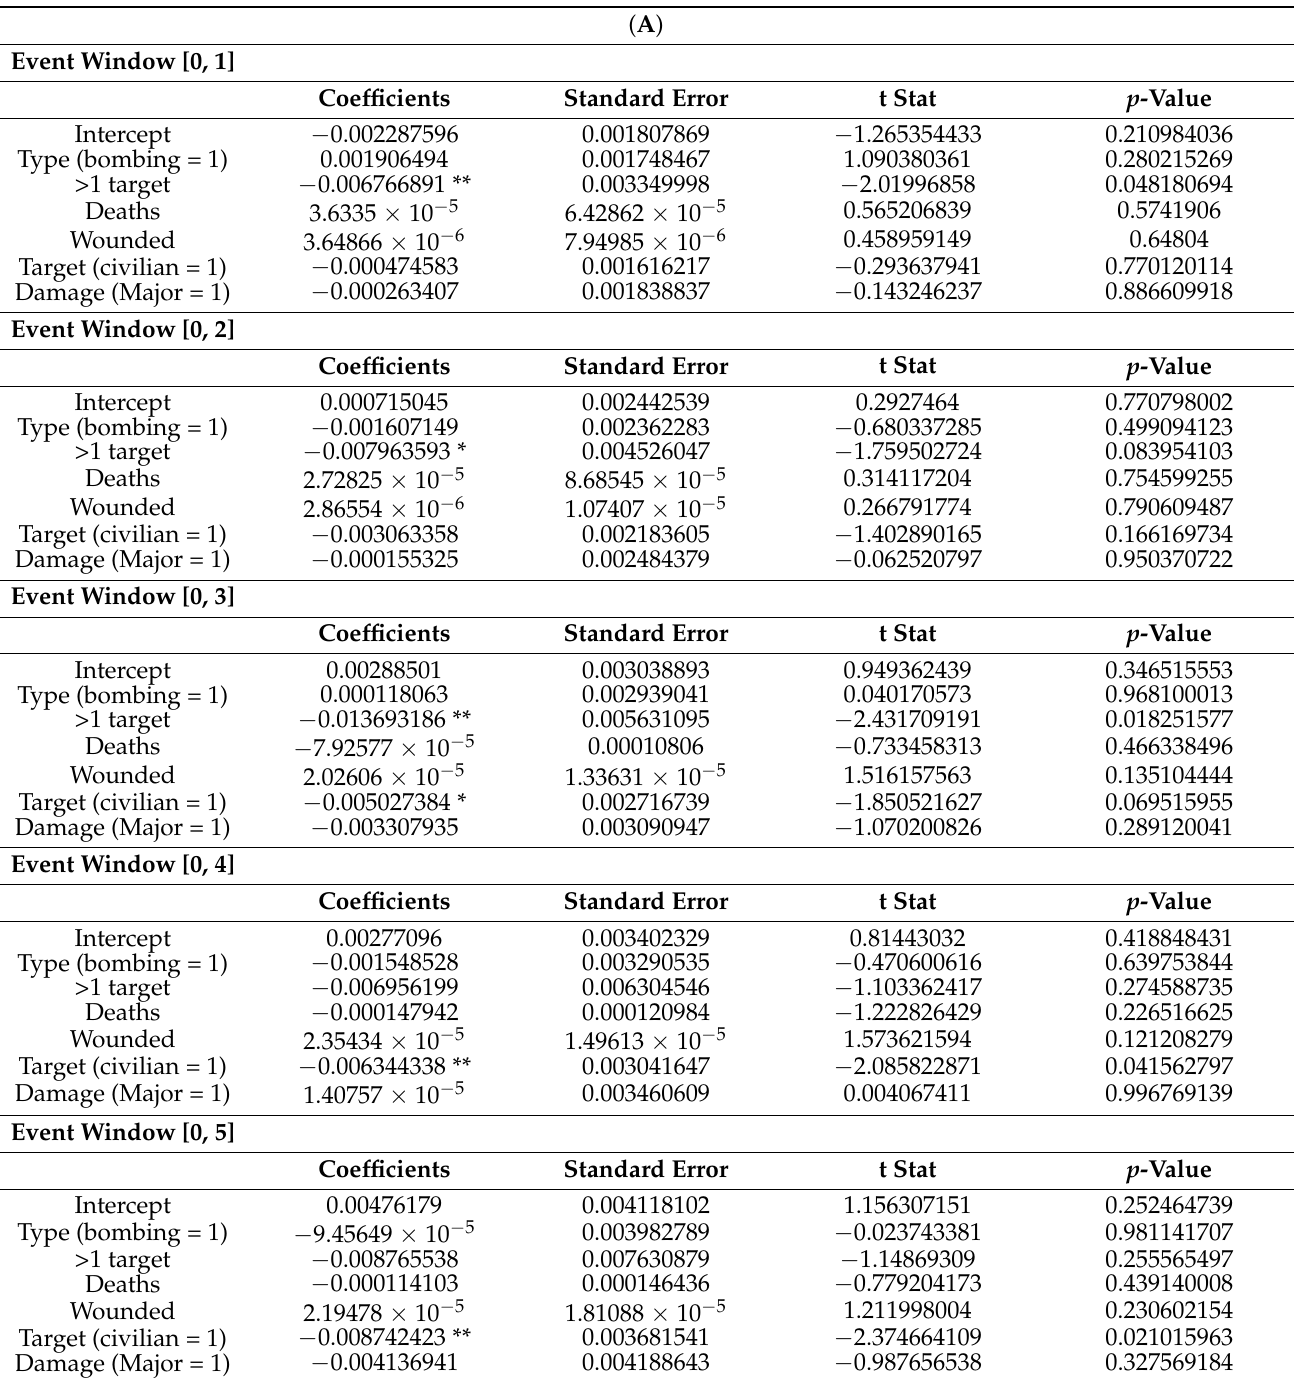
Table 6. ( A ). Cross-Sectional Regression Analysis of the Euro vs. the Dollar CAR. ( B ). Cross-Sectional Regression Analysis of the Euro vs. the Pound